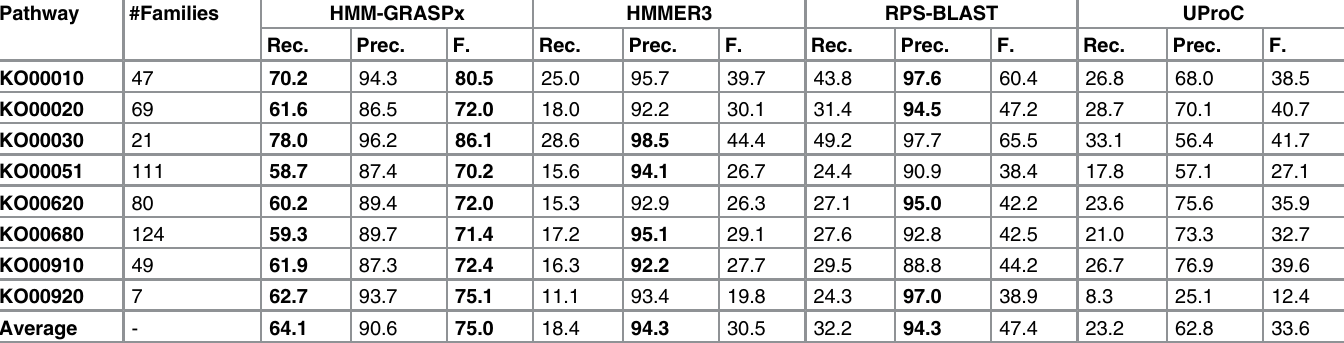
Table 1. Performances of the programs for searching metabolic protein family profiles against the simulated marine data set with uneven coverage. Pathway